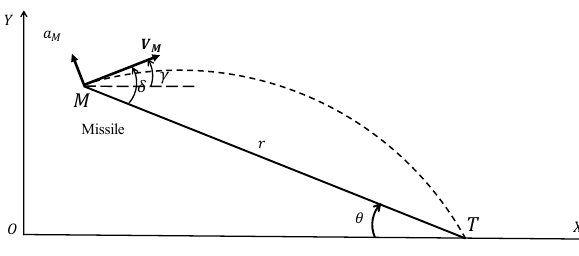
Figure 1. Planar engagement geometry.